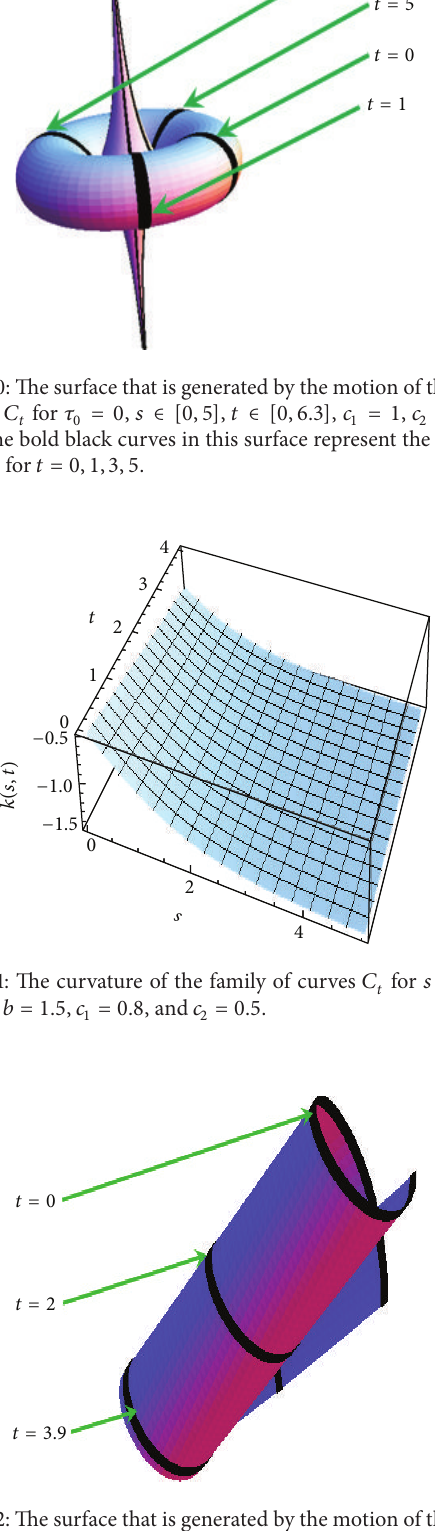
Figure 12: The surface that is generated by the motion of the family of curves 𝐶 𝑡 for 𝑠 ∈ [0, 8] , 𝑡 ∈ [0,3] , 𝑏 = 1.5 , 𝑐 1 = 0.8 , and 𝑐 2 = 0.5 . The bold black curves in this surface represent the family of curves 𝑡 = 0,1,2, 2.9 𝐶 𝑡 for